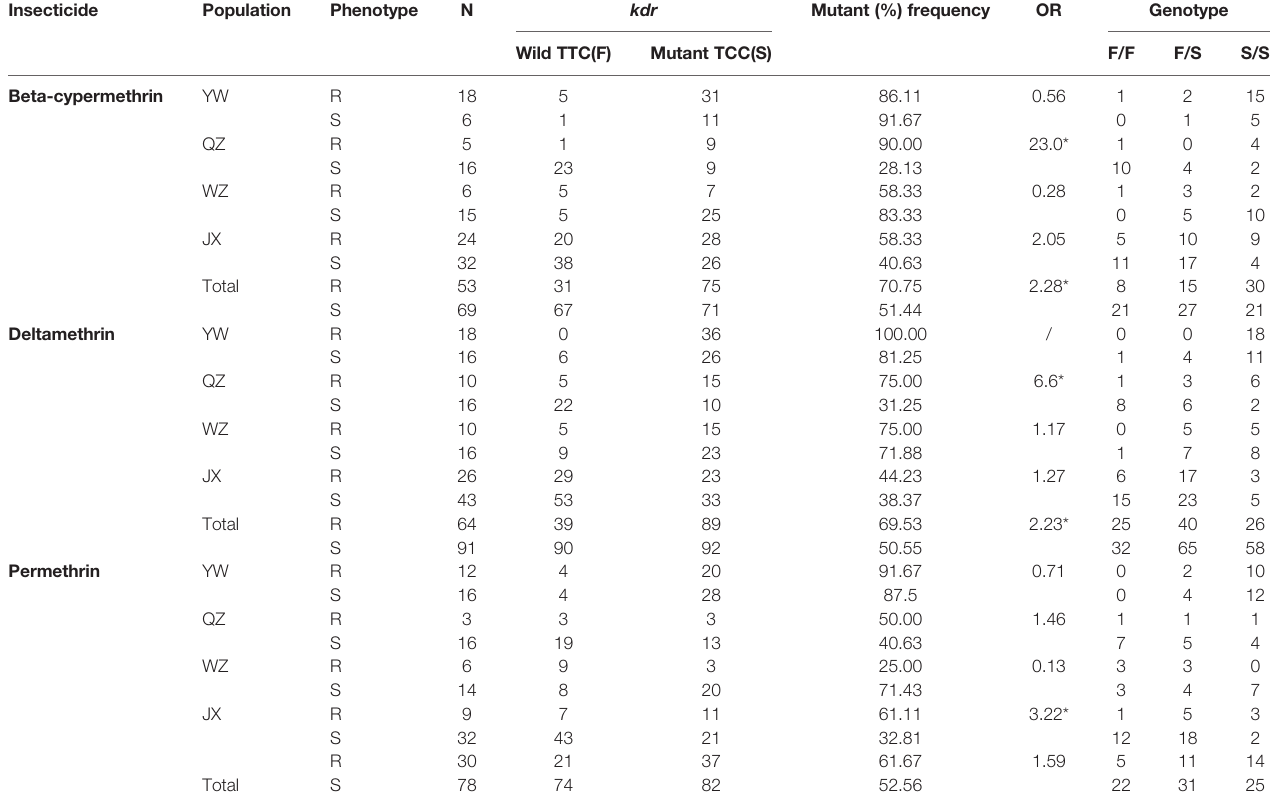
TABLE 1 | Kdr mutant allele frequency at codon 1534 from Ae. albopictus populations in YW, QZ, WZ, and JX from Zhejiang Province, China. Insecticide